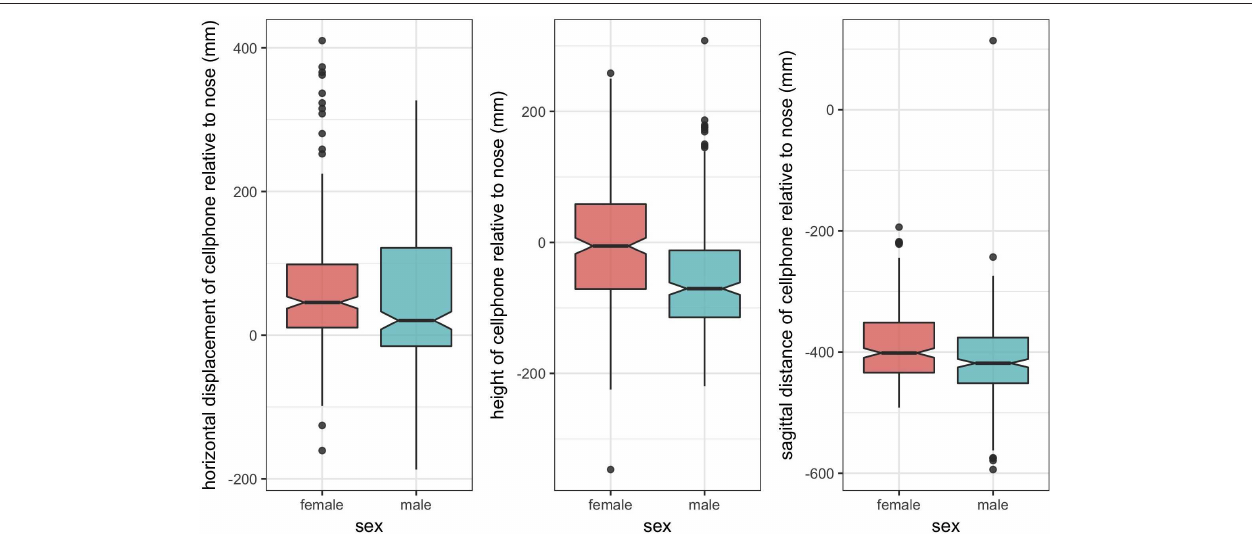
FIGURE 8 | Final positions of the smartphone relative to the participant’s nose on the x (horizontal), y (vertical), and z (sagittal) axes. Relative positions computed as the phone—nose difference. Thus, the zero points on the vertical axes indicate the position of the nose; positive values on the first plot indicate that the phone was to the right of the nose; on the second plot, that the phone was higher than the nose. On the third plot, larger negative values indicate larger distances. Box-plot conventions as in Figure 5 .